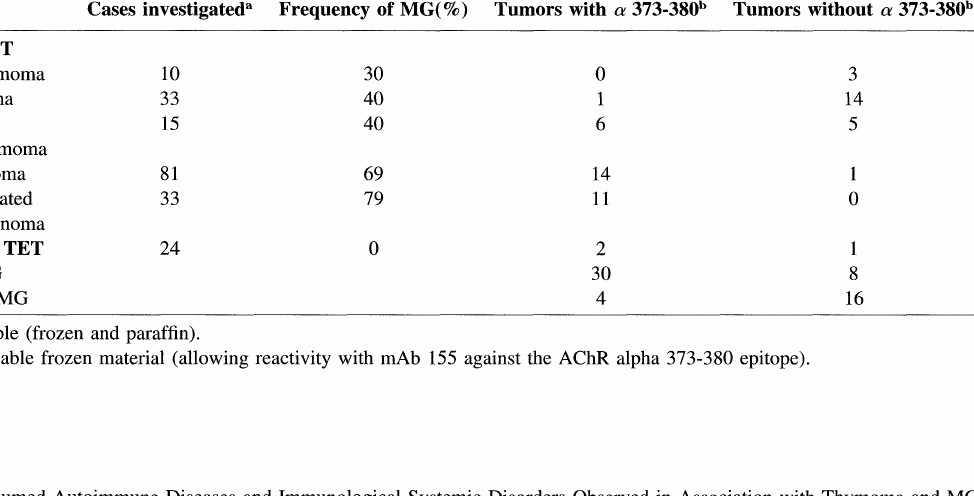
TABLE II Presumed Autoimmune Diseases and Immunological Systemic Disorders Observed in Association with Thymoma and MG Pure red-cell aplasia; Hypogammaglobulinemia; white blood cells aplasia; autoimmune hemolytic anaemia Grave’s disease (Morbus Basedow), Hashimoto thyroiditis Lupus erythematodes, rheumatoid arthritis, polymyositis, Sj6gren’s disease Subacute motor neuropathy Vitiligo, alopecia areata, bullous dermatoses Wegener’s granulomatosis, Crohn’s disease, Sarcoidosis Sources: aRosai, 1996; Marx et al., 1996ab; and Andonopoulos et al.,